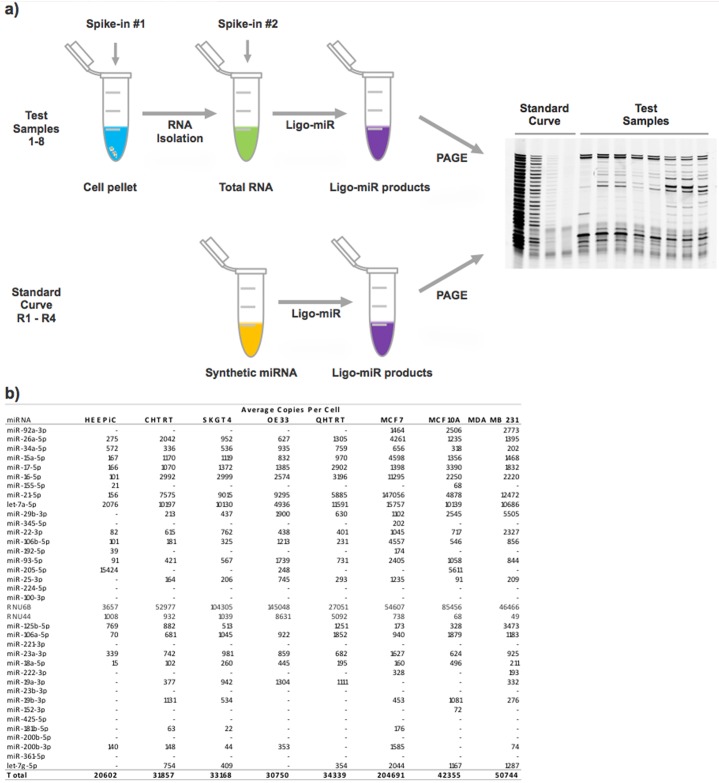
Absolute miRNA copy number using Ligo-miR EZ.a) Schematic illustration of Ligo-miR EZ method for determining absolute copy number by using spike-in controls and standard curve samples to normalize for reaction efficiencies and assay response. b) Absolute copy number profiles for 3 breast cell lines and 5 esophageal cell lines were determined using 4 overlapping Ligo-miR EZ panels.